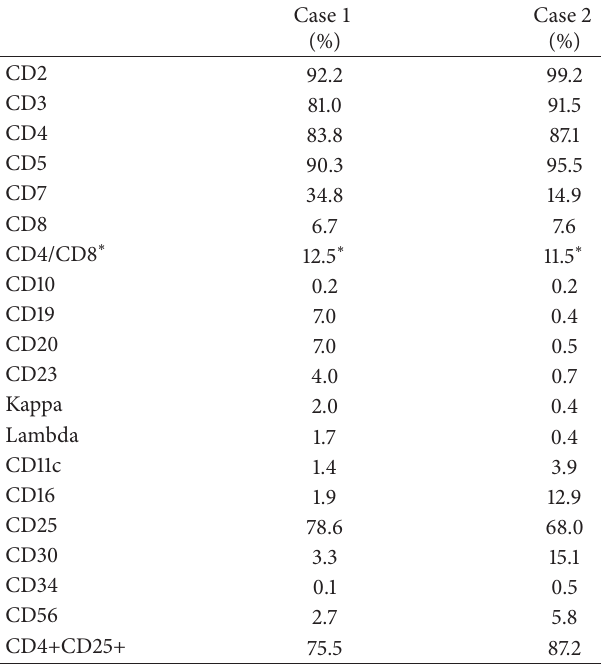
Table 2: Flow cytometric data of peripheral blood mononuclear